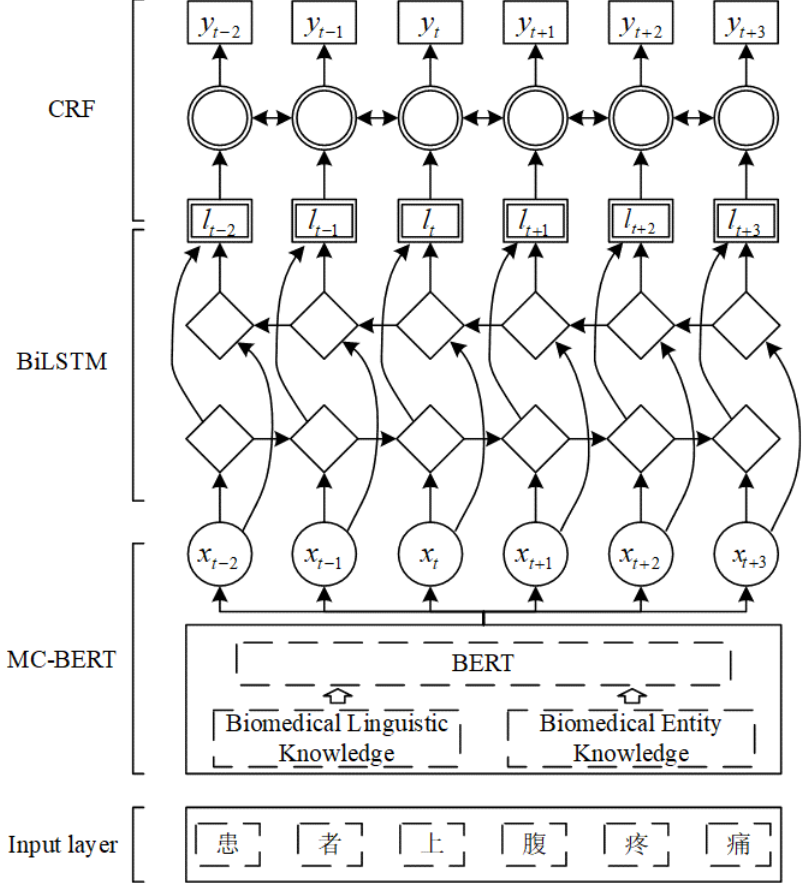
Figure 2. Sequence feature extraction framework based on MCBERT-BiLSTM-CRF. Note: “ 患者上腹疼痛 ” means “ the patient has epigastric pain ” .